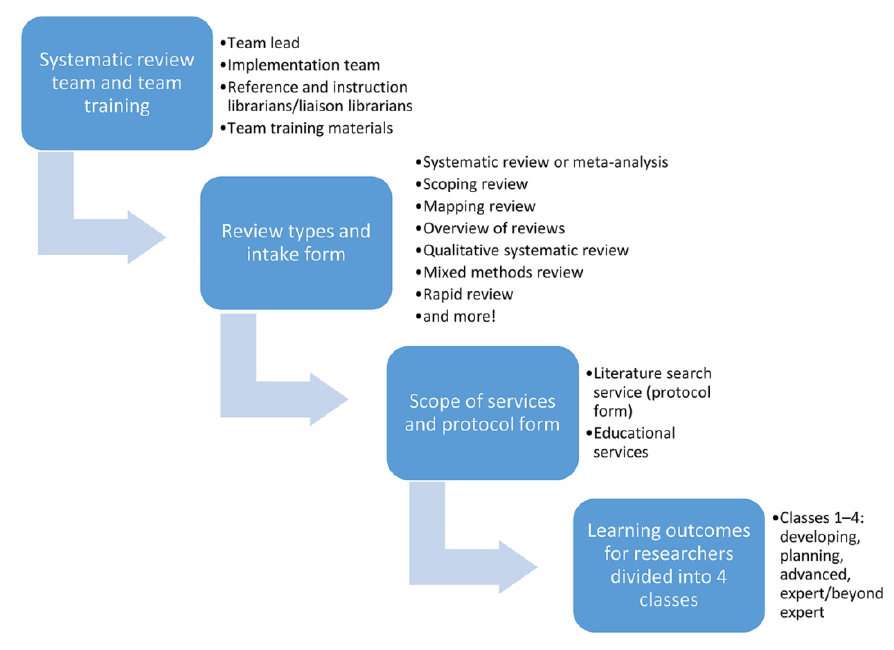
Figure 1 Team-based systematic review service